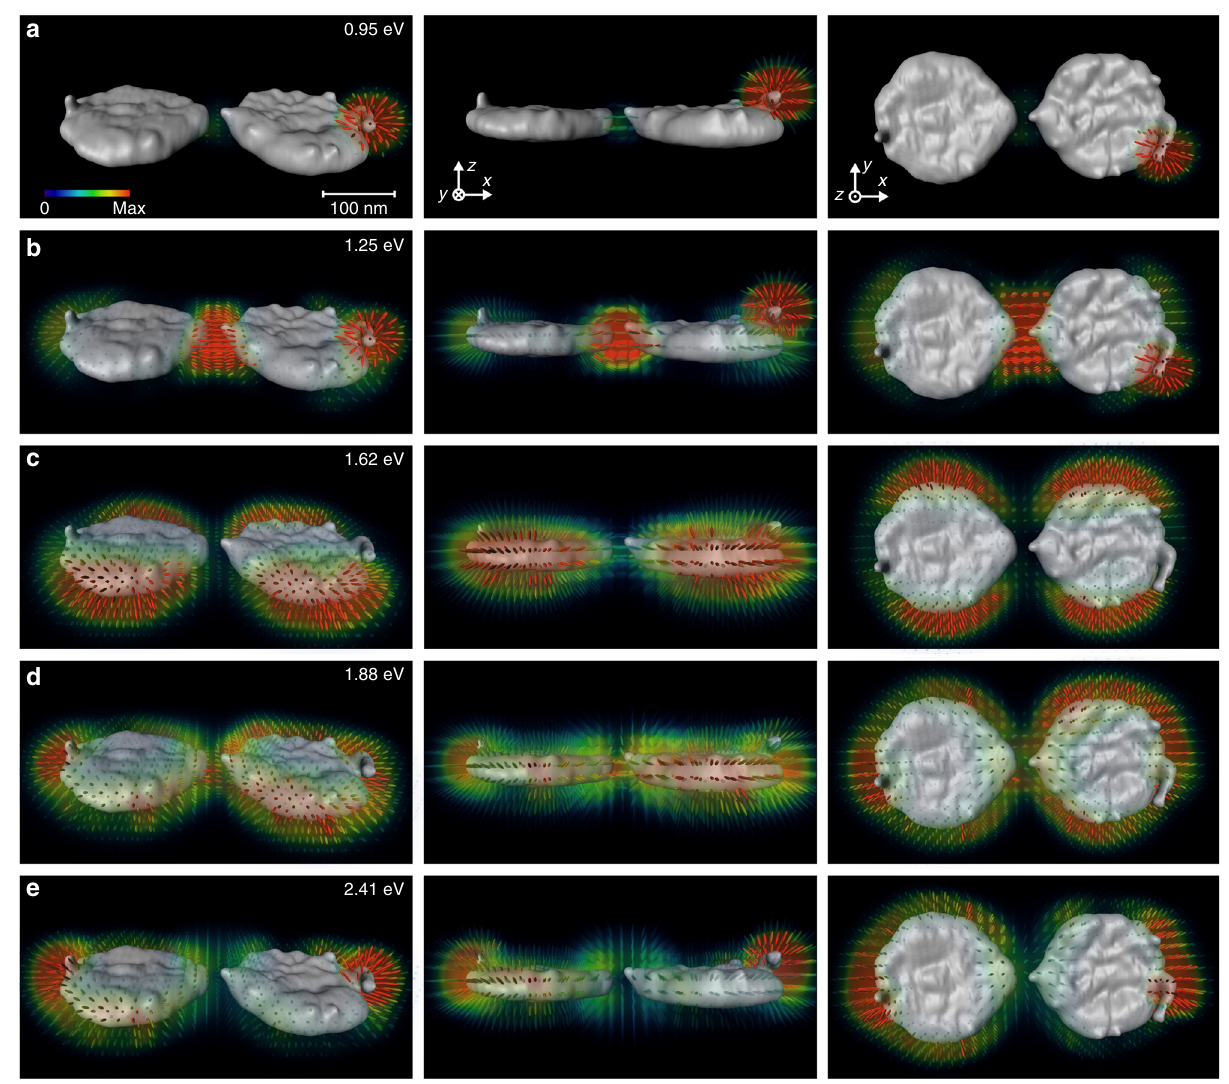
Fig. 4 Reconstructed LDOS for coupled disks. The reconstruction is done for the fi ve main peaks shown in Fig. 2e. The three columns show the LDOS from different viewing angles. a Localized plasmon mode at protrusion of right particle. For the other modes, the dipole moments of the disks are coupled in order of b → → , c ↑↓ , d ↑↑ and e →← . Mode d exhibits an additional hybridization with the quadrupolar disk